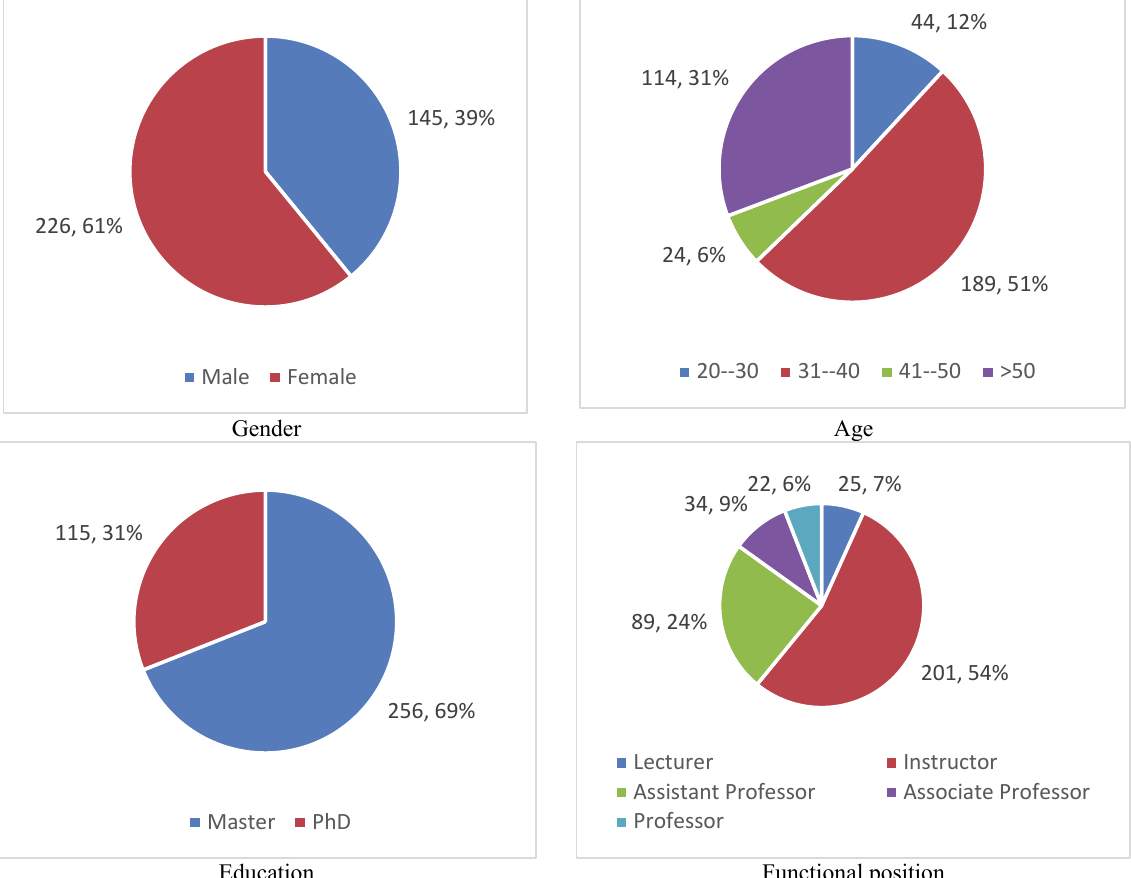
Fig. 2. Personal characteristics of the